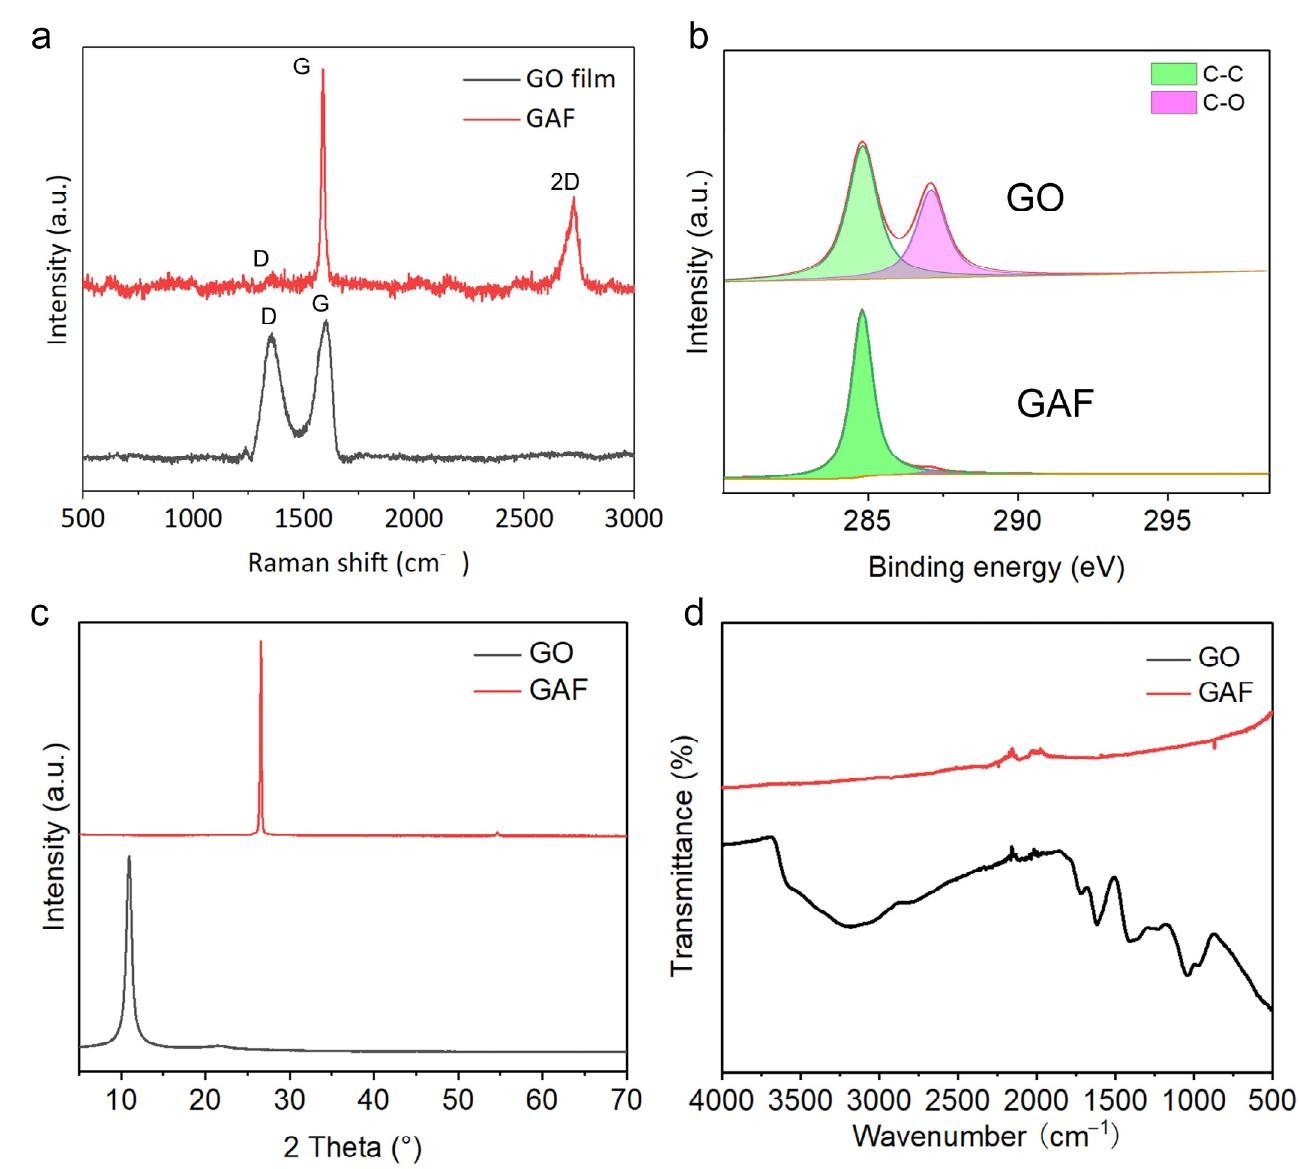
Figure 2. Characterizations of GO and GAF. ( a ) Raman spectra of GO and GAF. ( b ) XPS spectra of GO and GAF. ( c ) XRD patterns of GO and GAF. ( d ) FTIR spectra of GO and GAF.